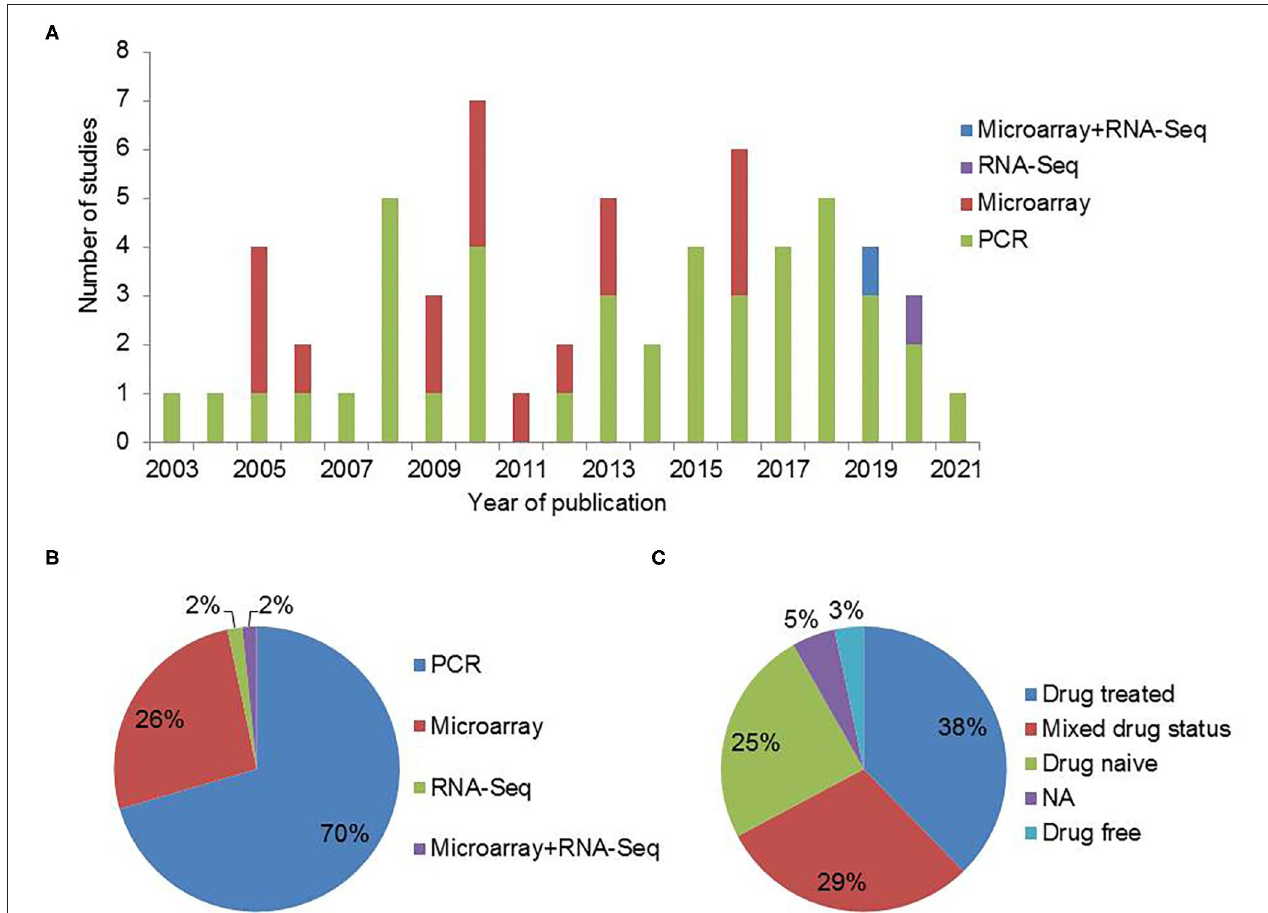
FIGURE 2 | Peripheral blood based gene expression studies in schizophrenia. (A) Gene expression studies for SCZ published over the years. (B) An overview of the methods used for gene expression analysis. (C) Type of participants included in the gene expression studies for SCZ (NA: Information not available).